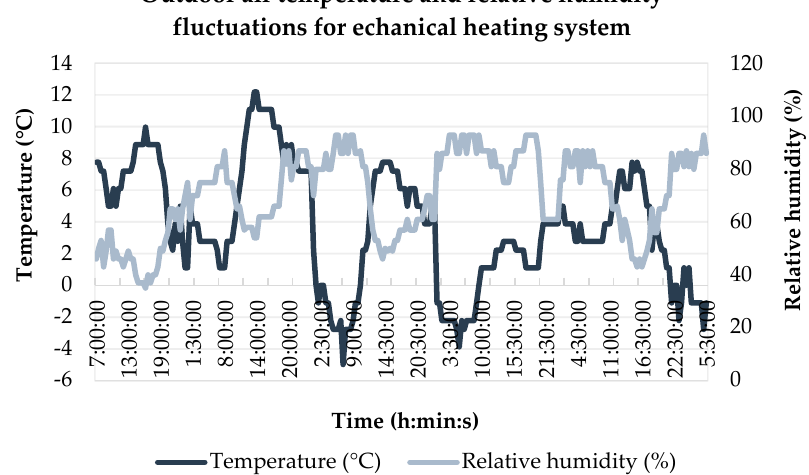
Figure 8. Outdoor air temperature and relative humidity fluctuations for RHS [32].